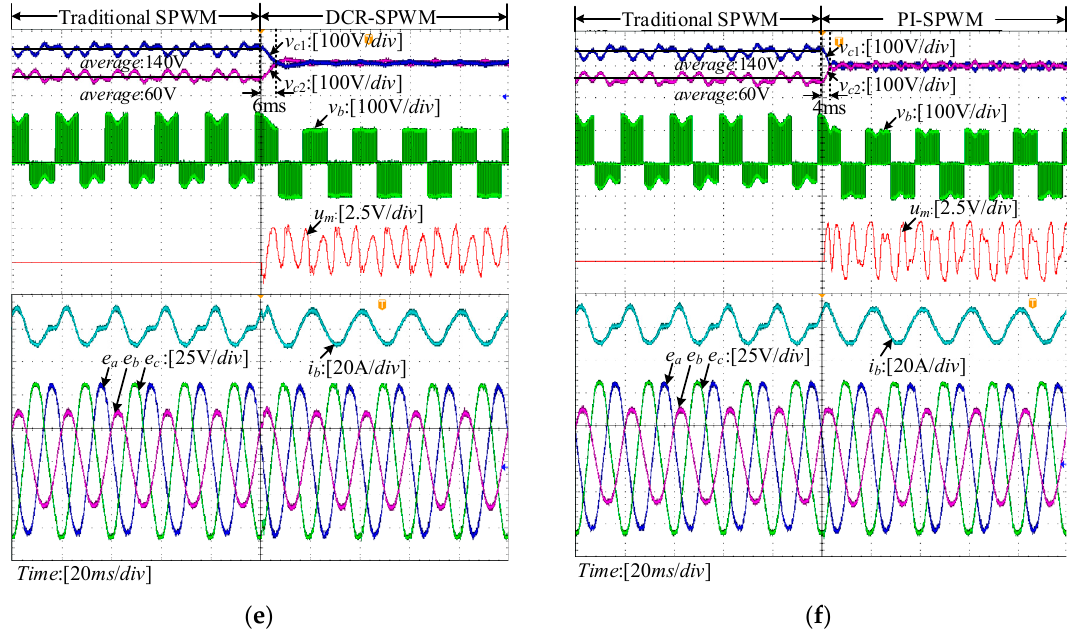
Figure 13. Experimental waveforms under dc unbalanced NP voltage conditions: ( a ) DCR-SPWM φ ui = 0, λ = 0.2, v c 1avg − v c 2avg = 80 V; ( b ) DCR-SPWM φ ui = − π /4, λ = 0.1, v c 1avg − v c 2avg = 80 V; ( c ) PI-SPWM φ ui = 0, λ = 0.2, v c 1avg − v c 2avg = 80 V; ( d ) PI-SPWM φ ui = − π /4, λ = 0.1, v c 1avg − v c 2avg = 80 V; ( e ) DCR-SPWM φ ui